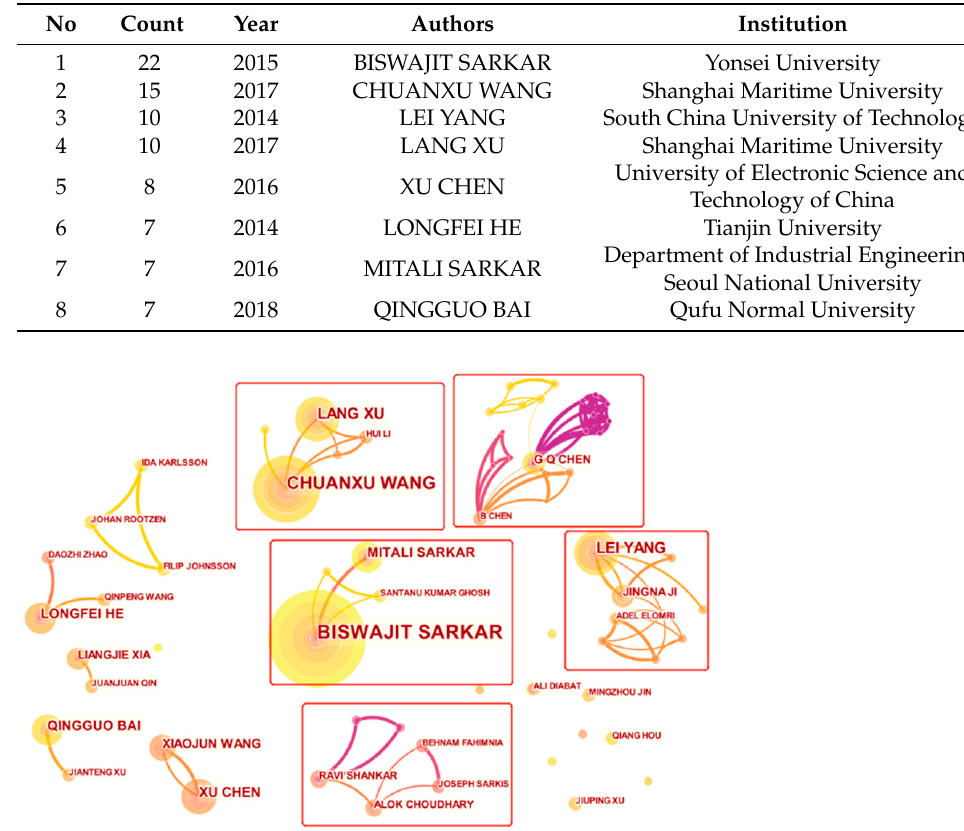
Table 2. Top 8 active authors.